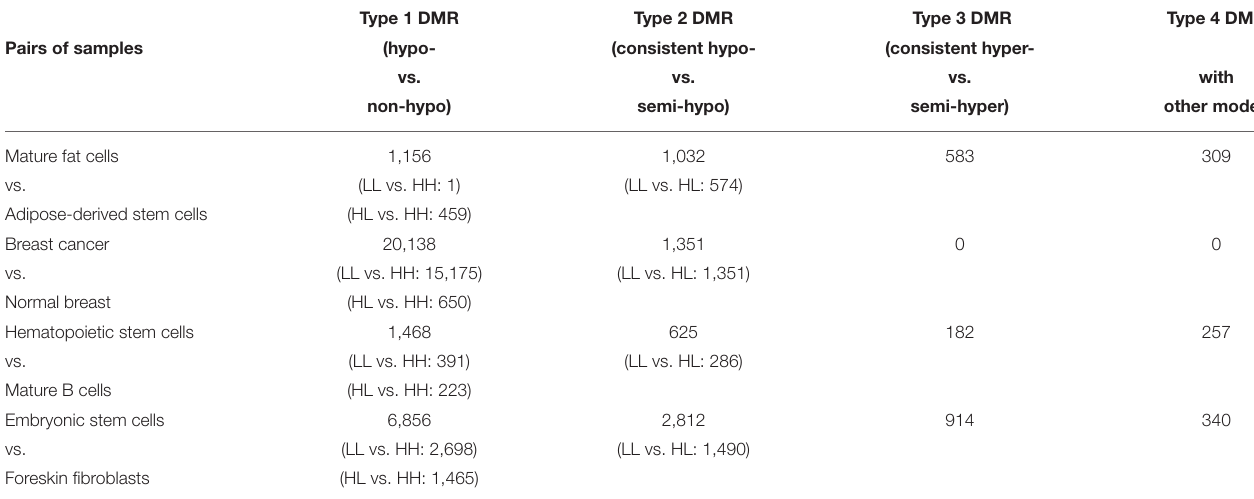
TABLE 3 | Four types of DMRs identified by MHap_DMR for each pair of